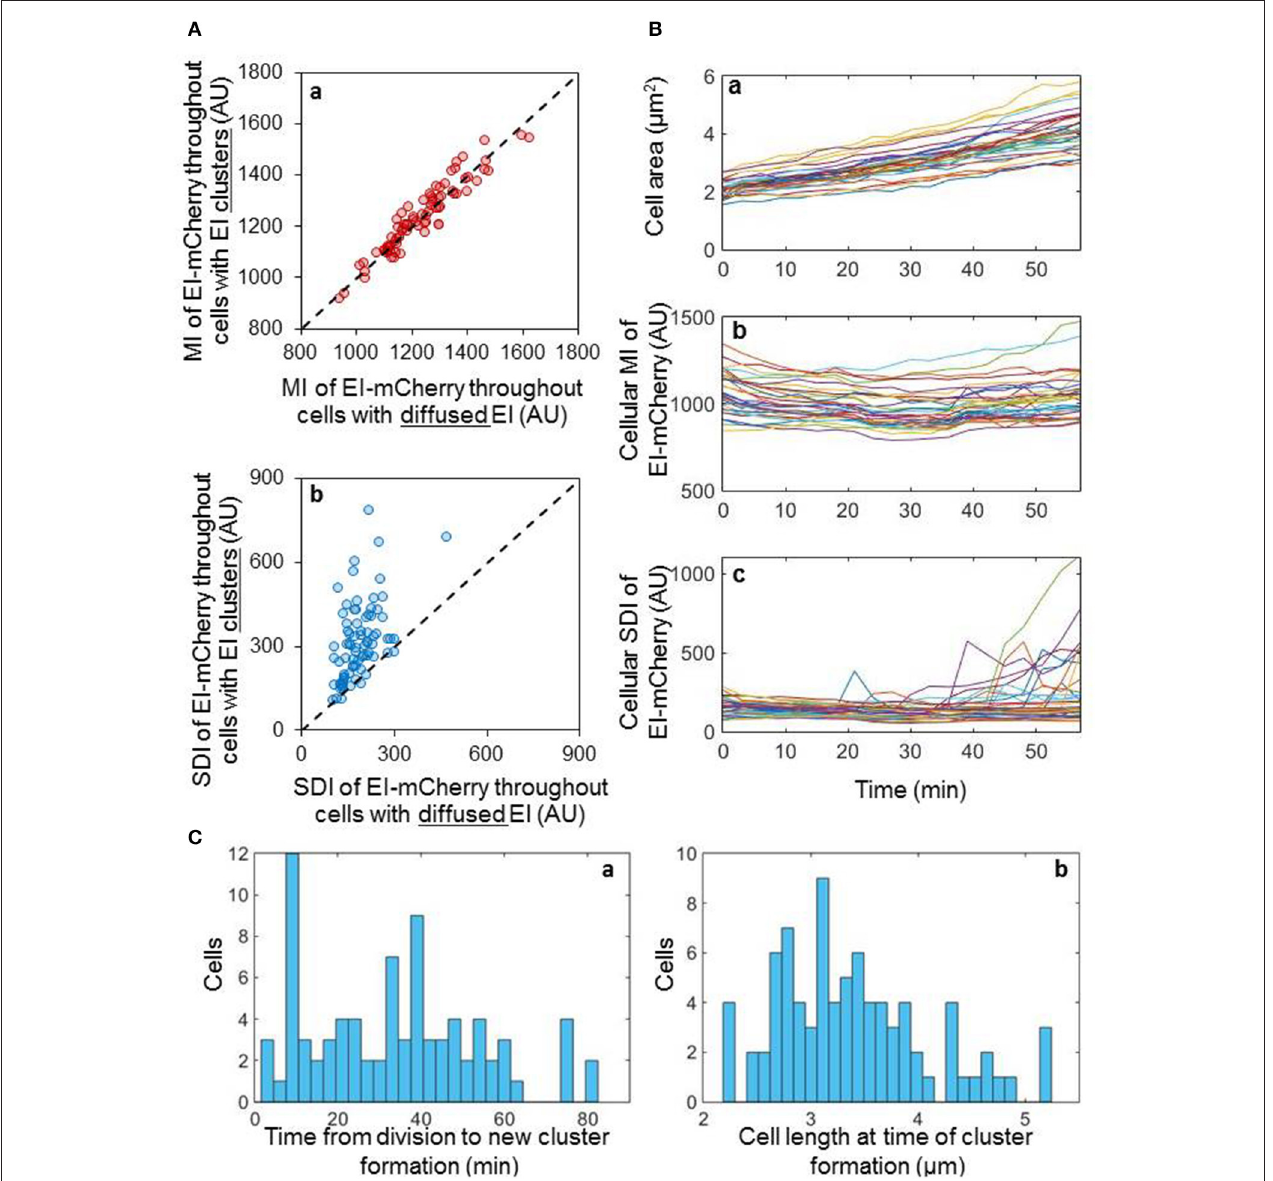
FIGURE 2 | EI clusters are formed by assembly of pre-existing dispersed molecules in a stochastic manner (A) Scatter plots of the cellular EI-mCherry mean intensity (MI) (a) or the cellular EI-mCherry standard deviation intensity (SDI) (b) for individual cells before cluster formation vs. after cluster formation ( n = 78). Dashed line, y = x . (B) Line charts showing the area (a) , MI (b) and SDI (c) of individual cells, in which EI-mCherry appeared diffuse at time 0, over 60min ( n = 36). (C) Distribution of the time it takes a new cluster to form from the time each cell has divided (a) and distribution of the cell length at the time a new cluster has formed in each cell (b) .